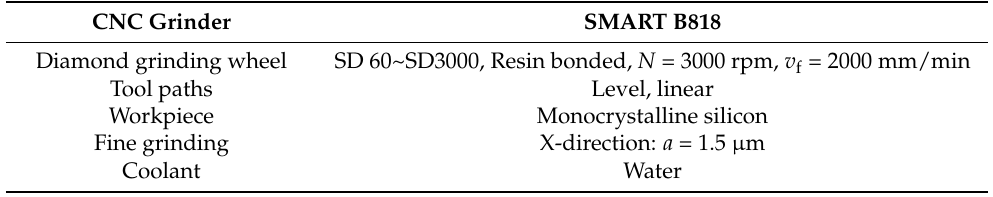
Figure 2. Schematic diagram of BLHS surface microground by a diamond grinding wheel. ( a ) The grinding of micro-nanogrooves; ( b ) the micro-grinding mechanism of the diamond grain; ( c ) the removal process of the involved micrograins on the grinding wheel tip surface. Table 1. Microgrinding conditions.